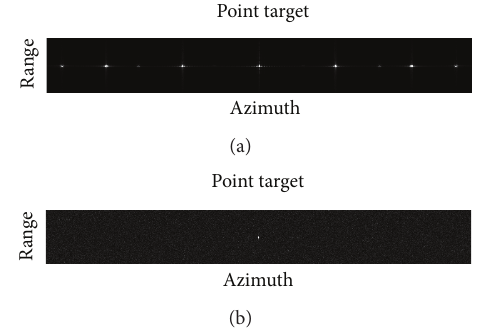
Figure 5: Imaging of the target point. (a) With phase errors. (b) Without phase errors.